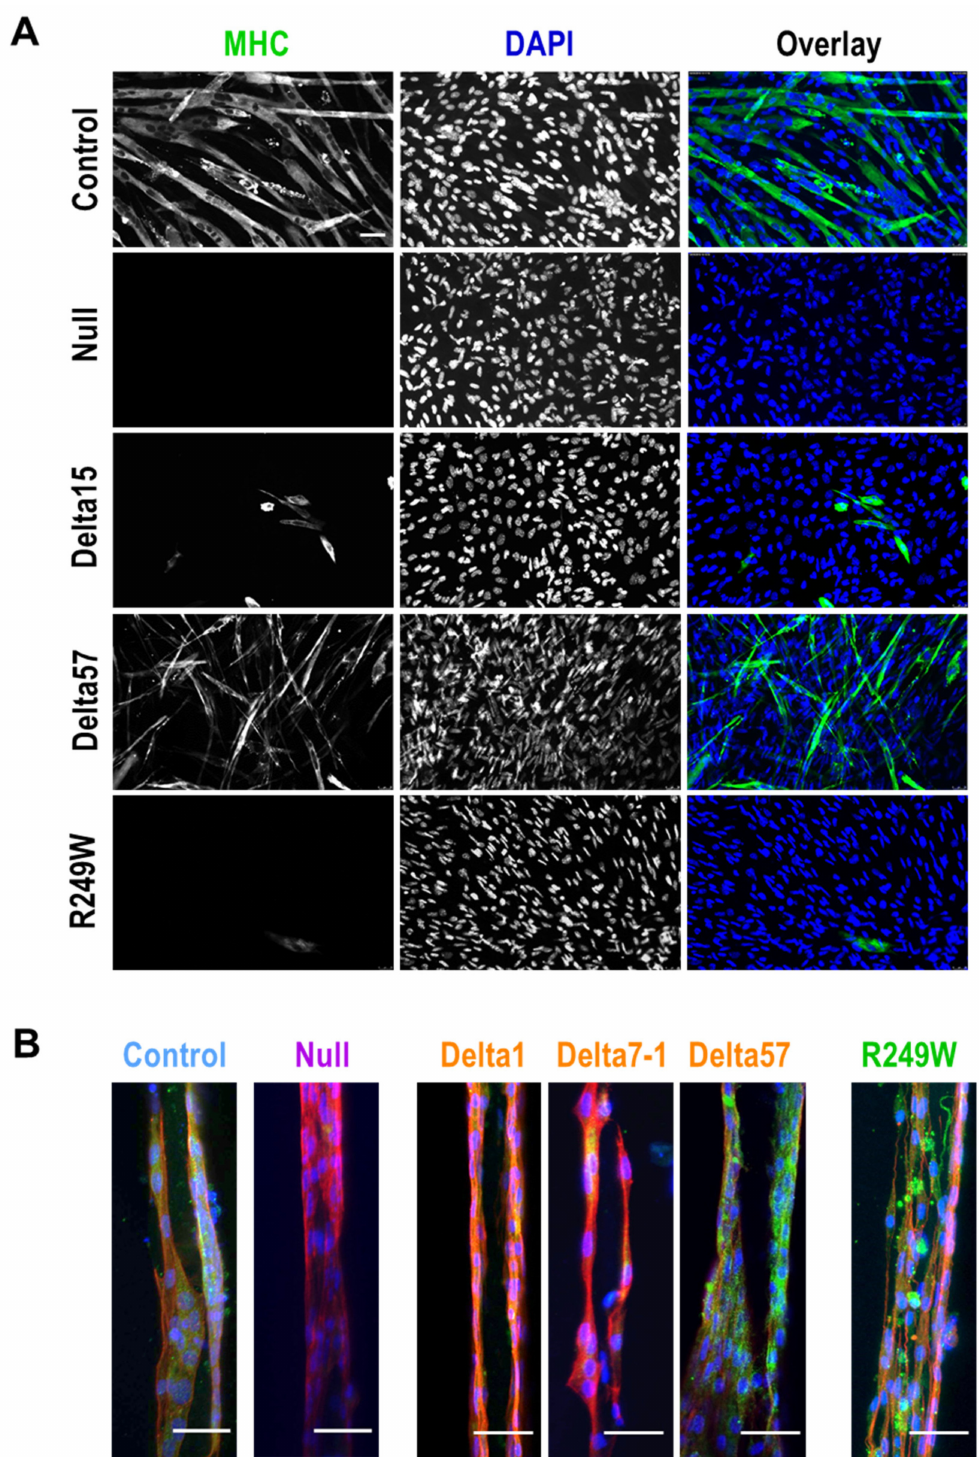
Figure 4. Myogenic di ff erentiation was impaired in mouse myoblasts with mutations in Lmna exon 4. ( A ) Myoblasts growing in 2D conditions were induced to di ff erentiate to myogenic fiber as described in Section 2. Representative pictures show myosin heavy chain (MHC, green) and nuclei (DAPI, blue). Scale bar = 60 µ m. ( B ) Myogenic fiber formation was also a ff ected in 3D models. Representative pictures show, at 7 days post-di ff erentiation, myosin heavy chain 7 (green), nuclei (blue), and phalloidin staining (red). Control and null samples correspond to 459-A6 and g12Lm2-3 clones. Scale bar = 50 µ m. Single color channels for this panel are shown in Figure